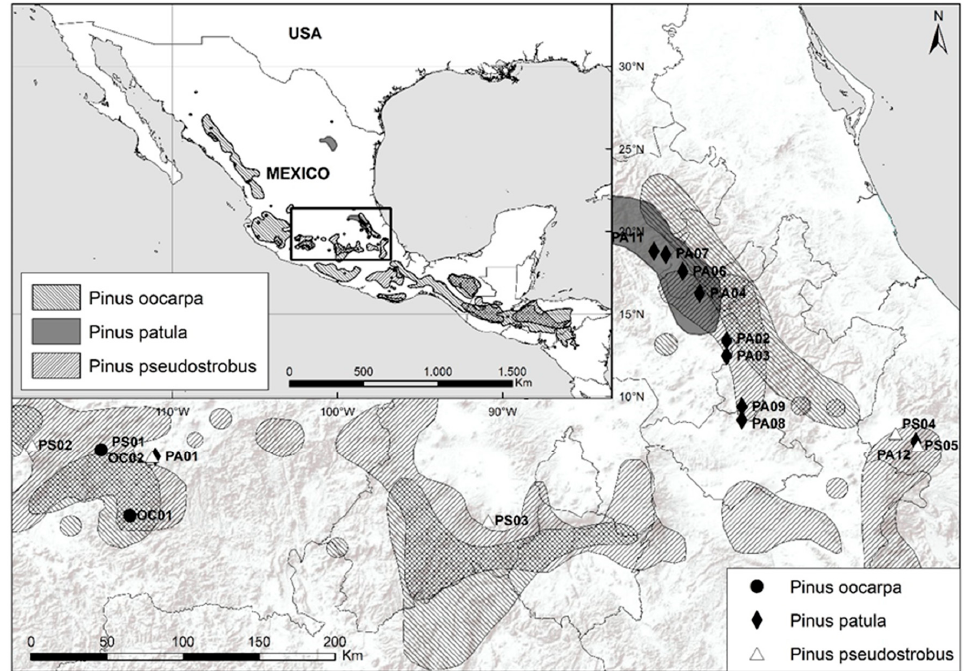
Figure 1. Location of sampled populations and distribution range of the species [19] for Pinus oocarpa , P. patula and P. pseudostrobus .